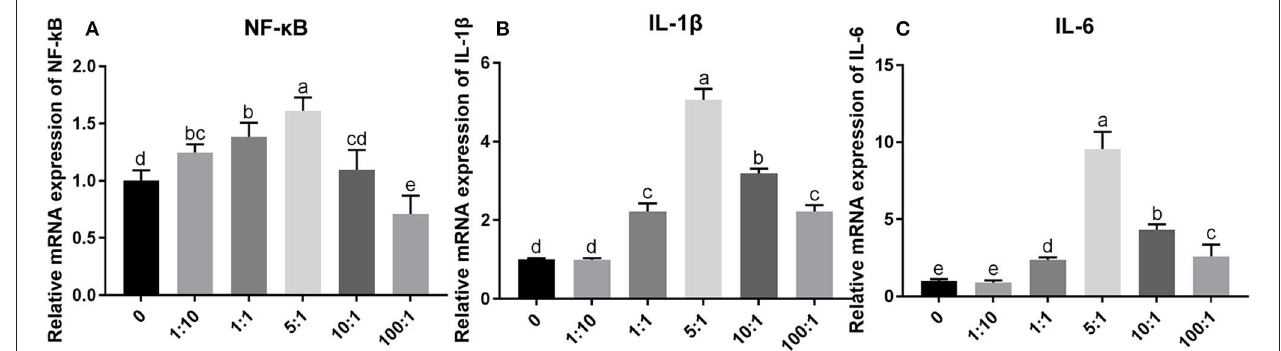
FIGURE 7 | The relative mRNA expression of inflammatory cytokines induced by E. coli with different MOIs. The SEECs were non-treated or treated with five different MOIs of E. coli for 3h, and the total RNA was isolated, followed by qPCR to detect the expression of NF- κ B, IL-1 β , and IL-6. (A) The relative mRNA expression of NF- κ B induced by E. coli with different MOIs. (B) The relative mRNA expression of IL-1 β induced by E. coli with different MOIs. (C) The relative mRNA expression of IL-6 induced by E. coli with different MOIs. Data are represented as the mean ± SD of three independent experiments with mixed SEECs from 15 sheep. Values with different lowercase letters were considered as statistically significant ( P <